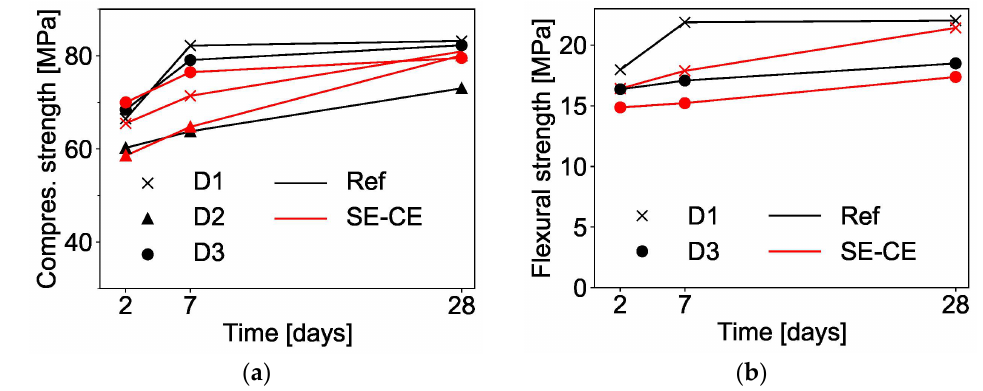
Figure 16. ( a ) Compressive strength and ( b ) flexural strength of printed SHCC.